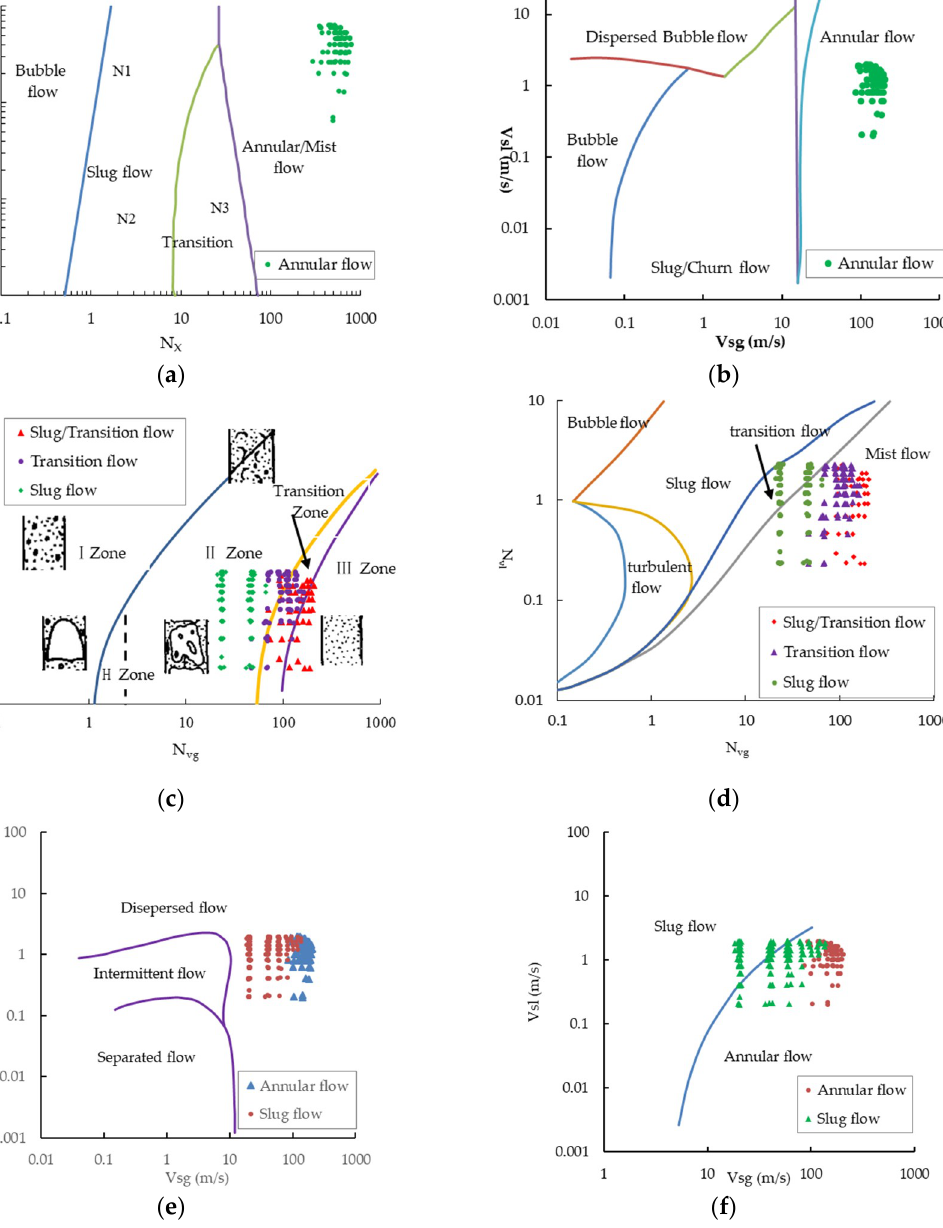
Figure 5. Verification of flow pattern maps: ( a ) Flow pattern map of Aziz; ( b ) Flow pattern map of Ansari; ( c ) Flow pattern map of Duns and Ros; ( d ) Flow pattern map of Gould; ( e ) Flow pattern map of Beggs–Brill; ( f ) Flow pattern map of Mukherrjee. V sg —the superficial gas velocity; V sl —the superficial liquid velocity; N vg —gas phase velocity criterion; N vl —liquid phase velocity criterion; N x —gas phase correction parameter; N y —liquid phase correction parameter.